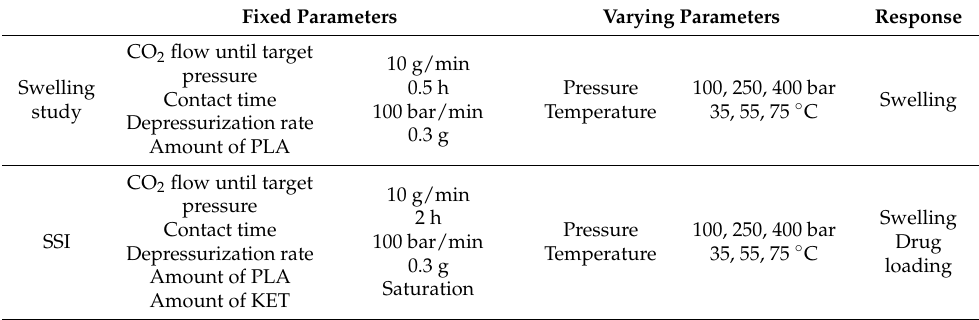
Table 1. Experimental design to swell and impregnate PLA with ketoprofen using scCO 2